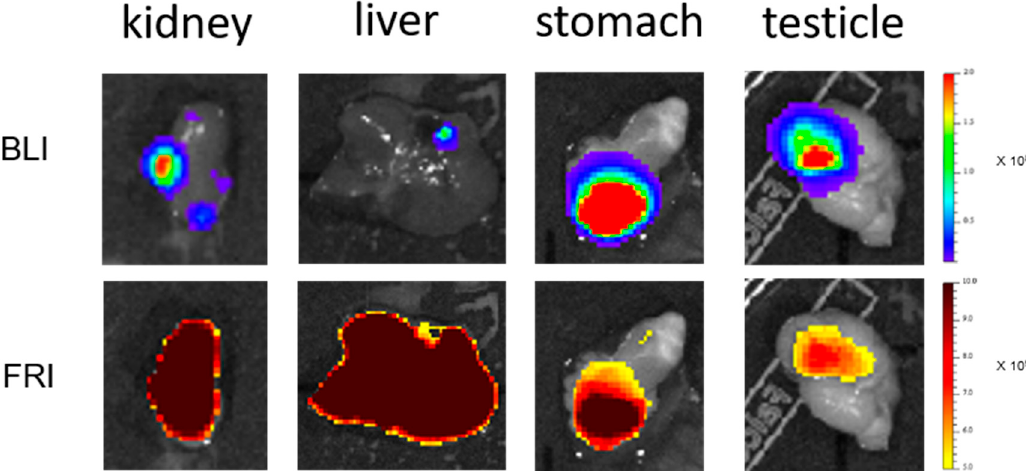
Figure 5. Ex vivo imaging of LipImage TM 815 accumulation in organs containing metastasis. BLI revealed the tumor location and FRI revealed LipImage TM 815 accumulation 6 h or 24 h after intravenous injection. In the kidneys and liver, LipImage TM 815 resulted in a disperse fluorescence signal without detectable accumulation in the metastasis; while in the stomach and testicles, fluorescence coincided with metastasis location. The FRI display scale is identical for all images